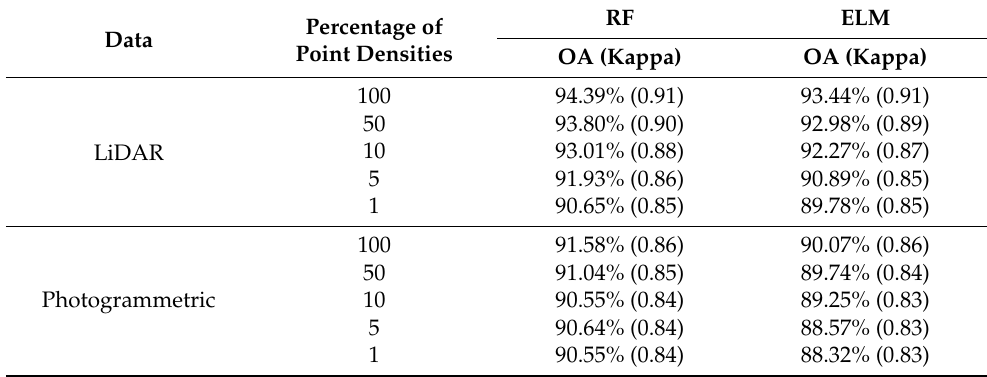
Table 8. Summary of classification accuracy levels using the RF and ELM based on the validation sample